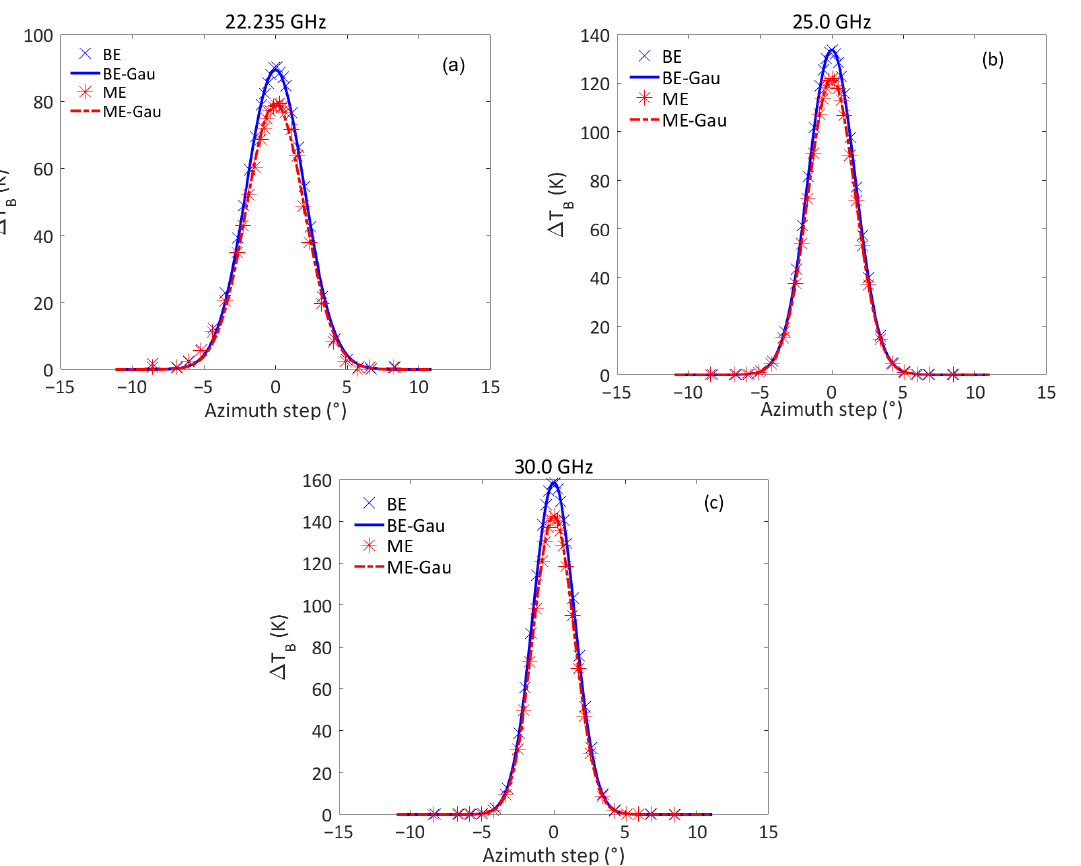
Figure 4. The variation of T B increment during the scanning of the sun at the azimuth on 26 December 2019. BE means “before eclipse” and ME means “maximum eclipse”. The dots are observed data and the line is a fitting of the Gaussian function (Gau). ( a ) 22.235 GHz, ( b ) 25.0 GHz, ( c ) 30.0 GHz.